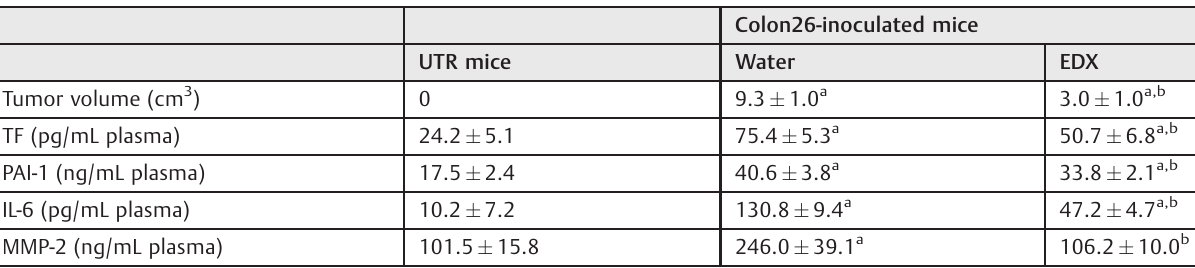
Table 3 Tumor volume and plasma levels of coagulation- and tumor-related factors in untreated (UTR) mice and Colon26- inoculated mice orally treated with water or edoxaban (EDX) daily for 21